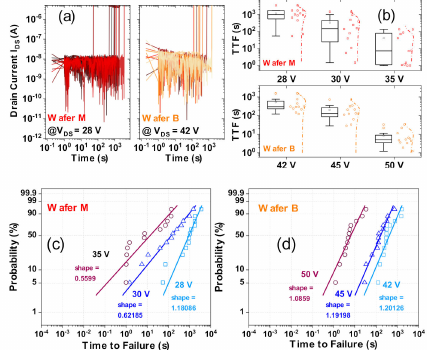
Figure 13. Constant voltage stress tests on Wafer M (uni-layer) and Wafer B (bilayer). ( a ) presents current plots for 12 tested devices at a V DS bias of 28 V for Wafer M and 42 V for Wafer B; ( b ) Time to Failure (TTF) dependence on stress voltage V DS for constant voltage stress tests on both wafers; ( c , d ) are probability distributions evaluated for Wafer M ( c ) and Wafer B ( d )